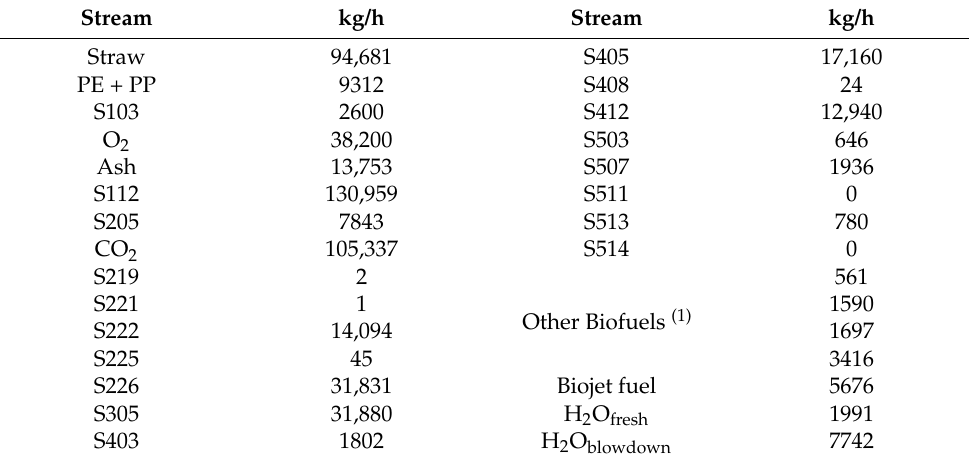
Figure 5. Overall mass balance. Table 7. Overall mass